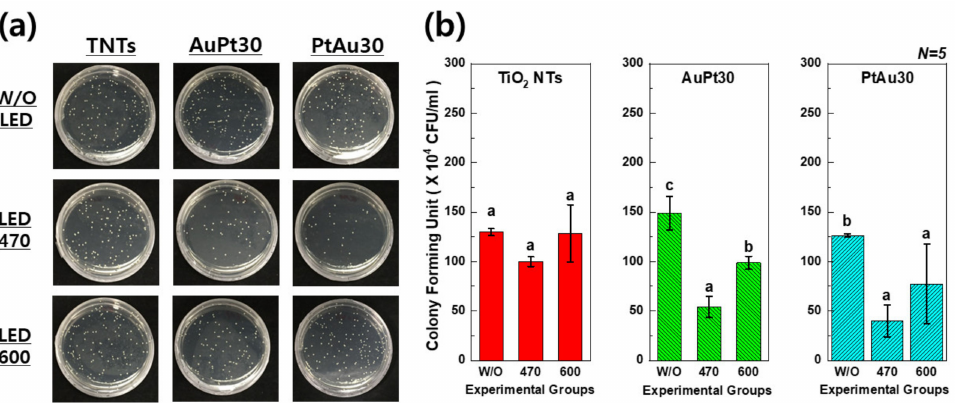
Figure 5. ( a ) Photo images of agar-based antibacterial activity test and ( b ) CFU values per unit volume of S. aureus . In the graph, W/O, 470, and 600 designate no irradiation, 470 nm irradiation, and 600 nm irradiation, respectively. Moreover, in each graph, the values of experimental groups with the same lowercase letter (a, b, or c) are not statistically different as determined by one-way ANOVA at α =